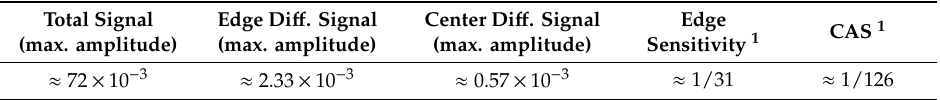
Table 2. Main results from the calculated signals, shown in Figure